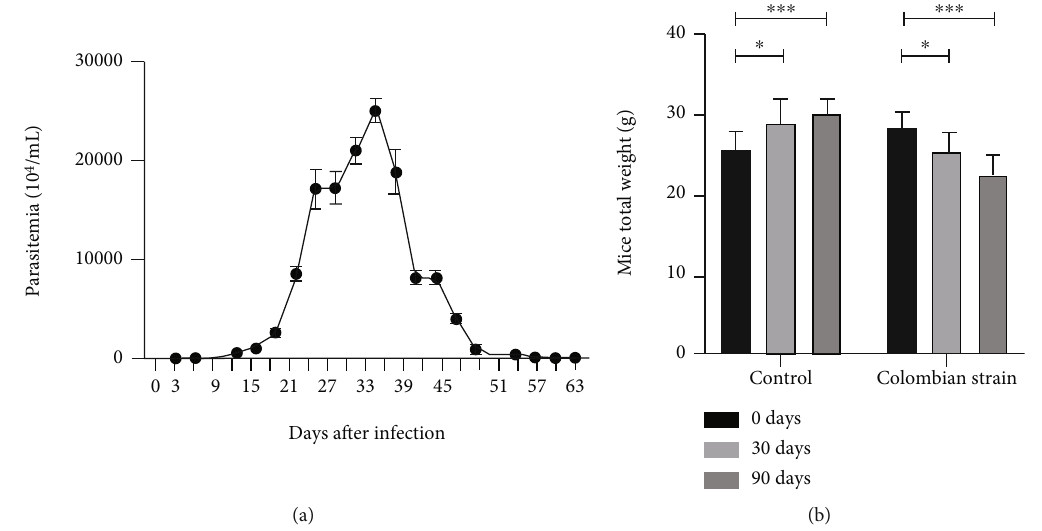
Figure 1: Blood parasitemia (a) and weight (b) di ff erences between the acute and chronic phases of T. cruzi Colombian strain infected C57Bl/6 mice. Two-way ANOVA test. ∗ Signi fi cant statistical di ff erences at p < 0 : 05